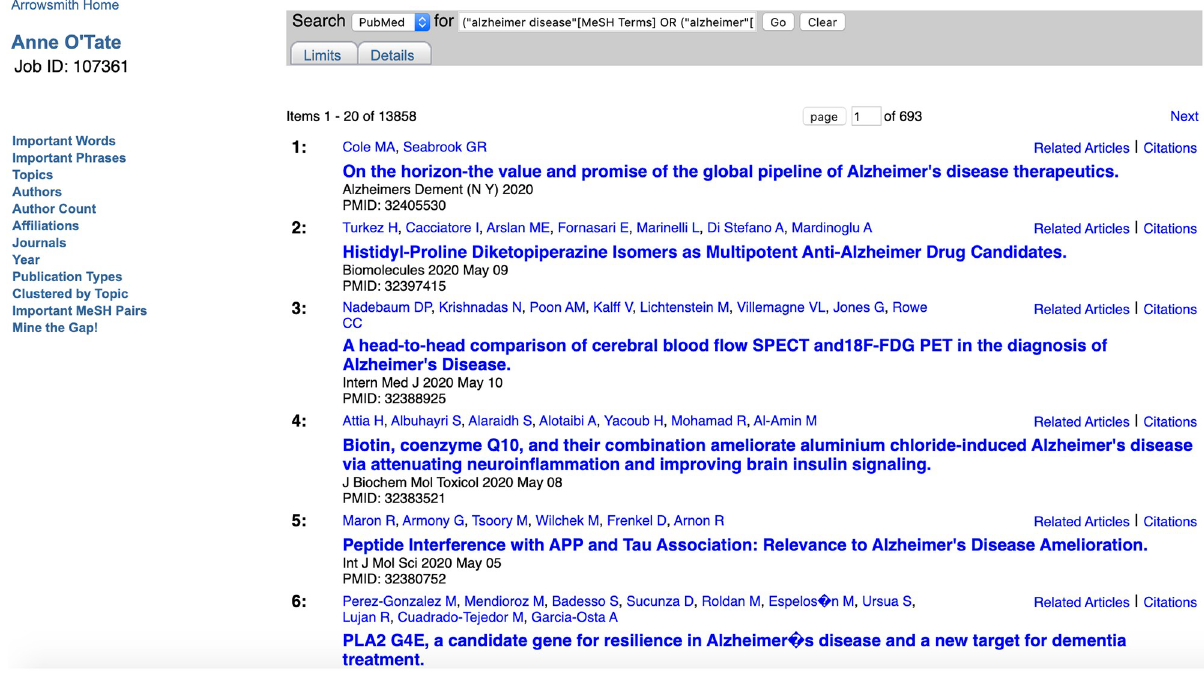
Fig 4. Screenshot of the list of articles that mention “amyloid” or “amyloids” within the original query.